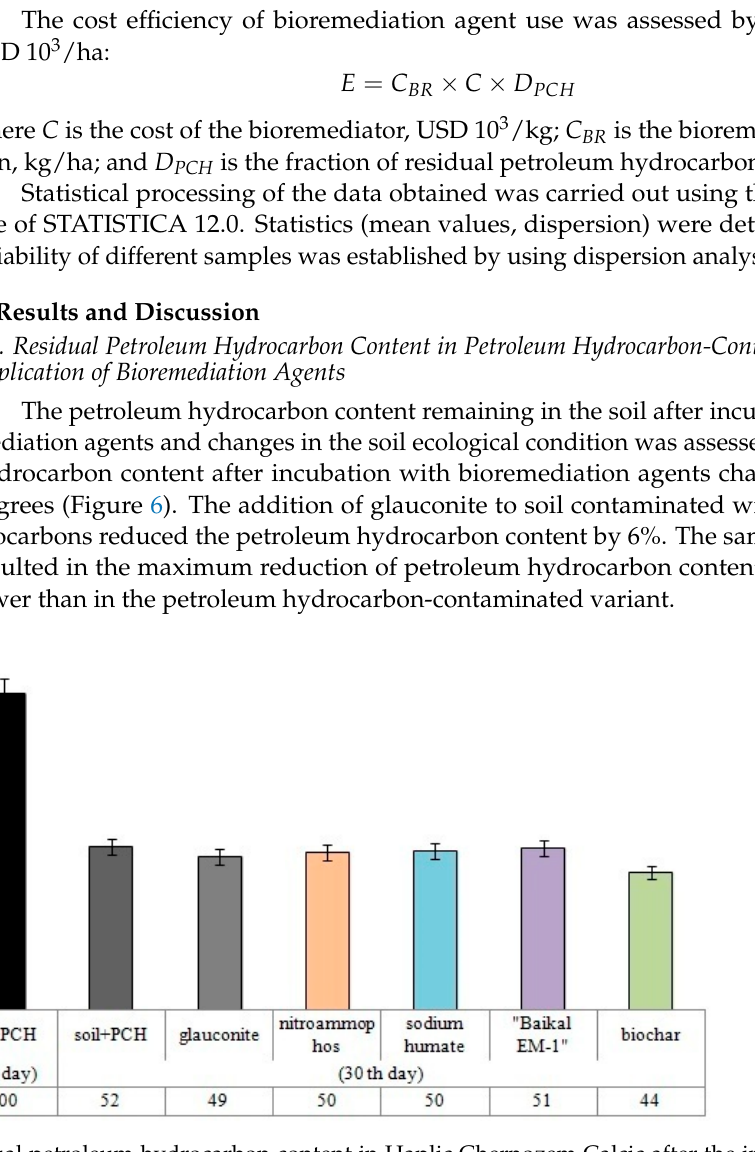
Figure 6. Change in the residual petroleum hydrocarbon content in Haplic Chernozem Calcic after the introduction of bioremediation agents after 30 days of incubation, % from the initial petroleum hydrocarbon content.